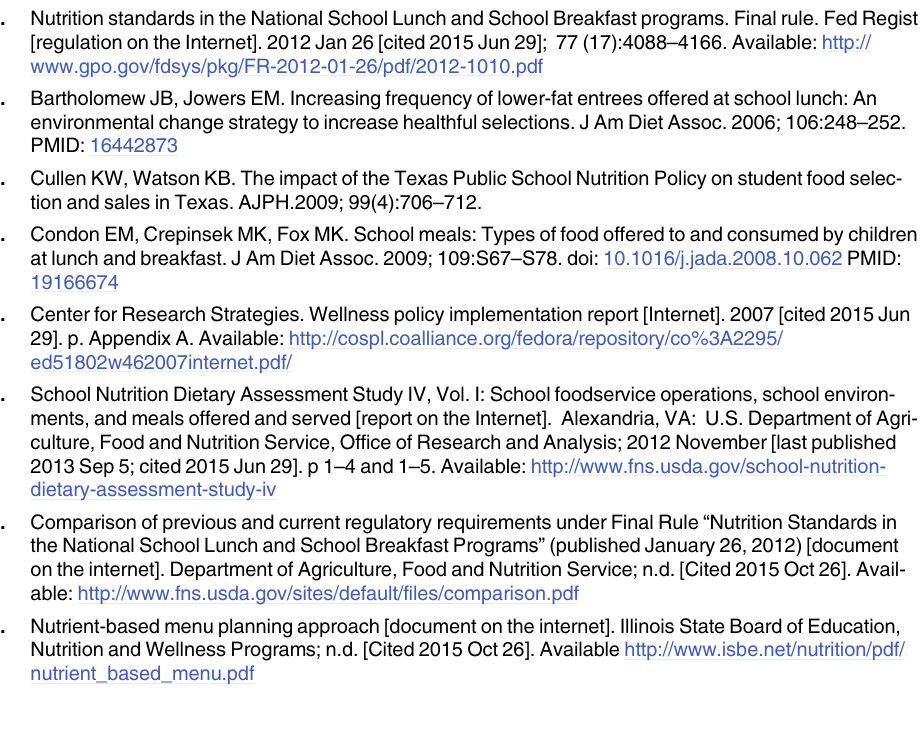
S1 Table. Example of data from 3 days of production sheets from one school, and the cod- ing applied by the evaluation Registered Dietician (R.D.), 2009 and